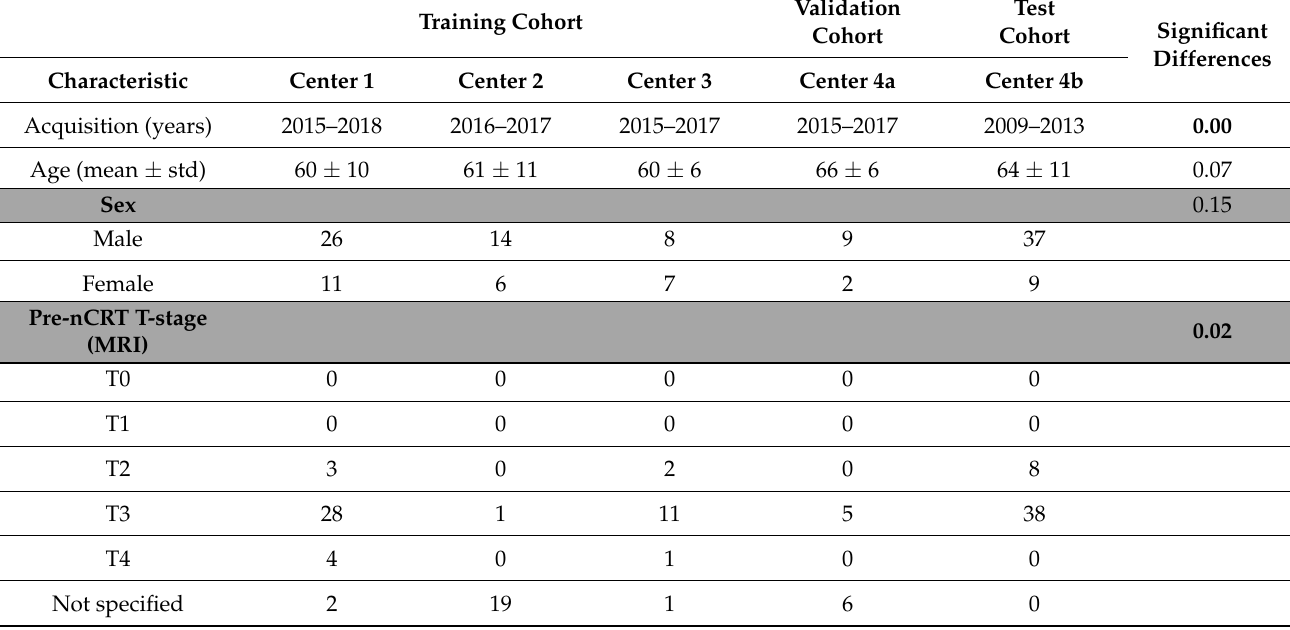
Table 1. Characteristics of patients in the training, validation and test cohort disaggregated by